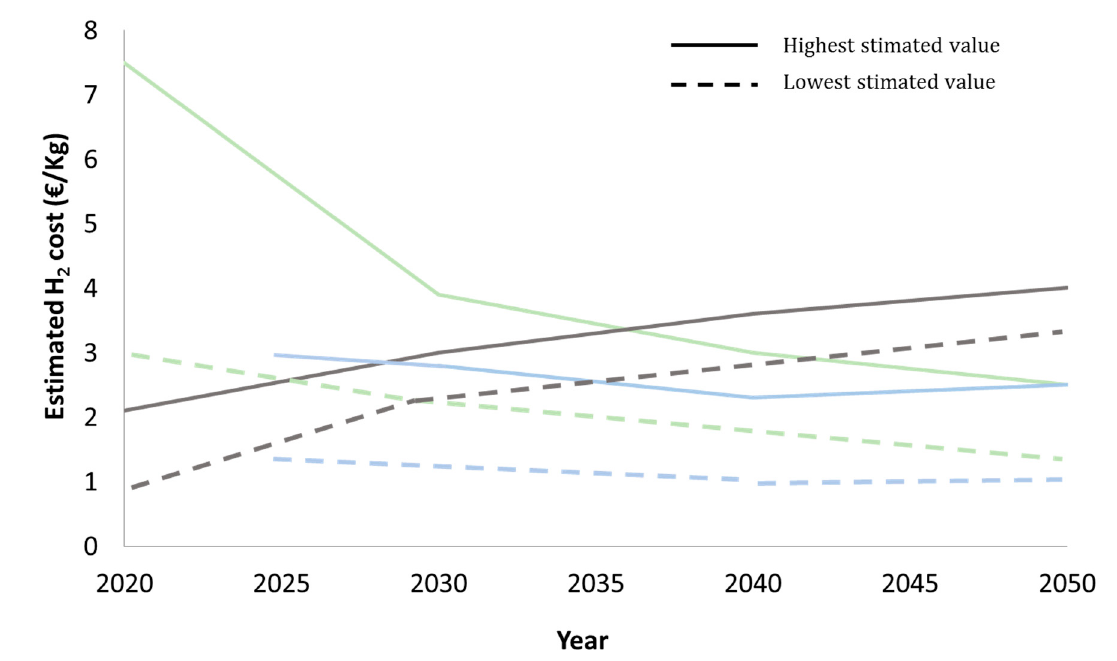
Figure 3. A comparative summary of estimated hydrogen production costs in the next two decades. (Green lines: green hydrogen; blue lines: blue hydrogen; grey lines: grey hydrogen).